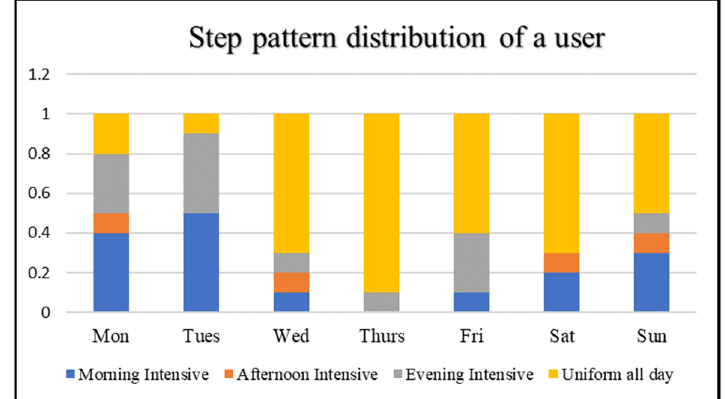
Figure 8. Daily step pattern of a user across all days of the